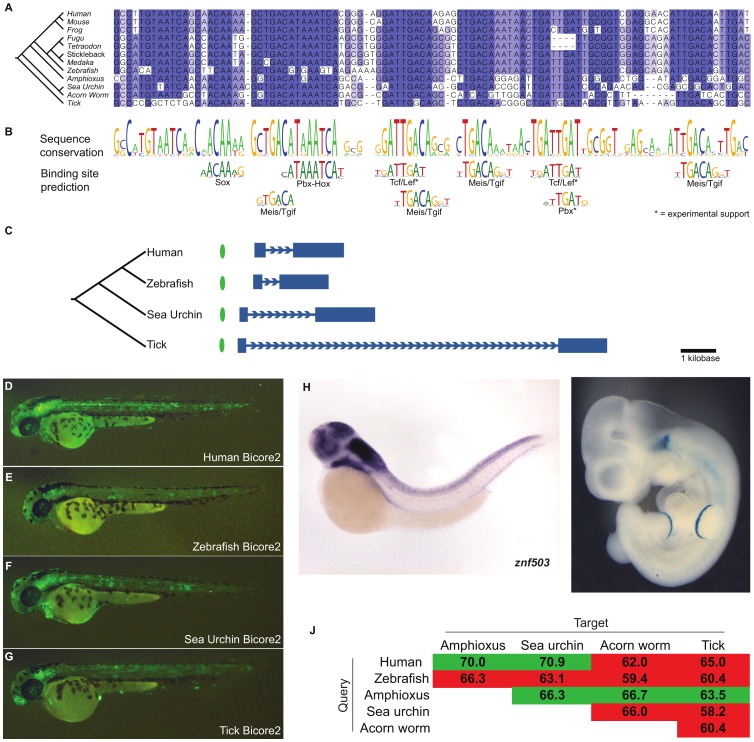
Bicore2 is a bilaterian conserved enhancer.(A) Multiple alignment of Bicore2. (B) Conservation profile of Bicore2 showing that conserved blocks in the alignment correspond to transcription factor binding preferences. (C) Each instance of Bicore2 (green oval) is syntenic to a conserved instance of Znf503 (blue gene structure). (D–G) Zebfrafish transgenic enhancer assay showing (D) human, (E) zebrafish, (F) sea urchin, (G) tick instances of Bicore2 drive expression in the hindbrain at 48 hours. (H) Whole-mount in situ hybridization of Znf503 shows expression in the hindbrain, courtesy of zfin.org. (I) A human region containing Bicore2 drives expression in the hindbrain and the apical ectoderm of the limb in embryonic day 11.5 mice. (J) Pairwise percent identities of Bicore2 sequences. Green cells indicate a query sequence (row) that detected Bicore2 in the target (column). Red cells indicate query sequences that did not detect Bicore2 in the target.